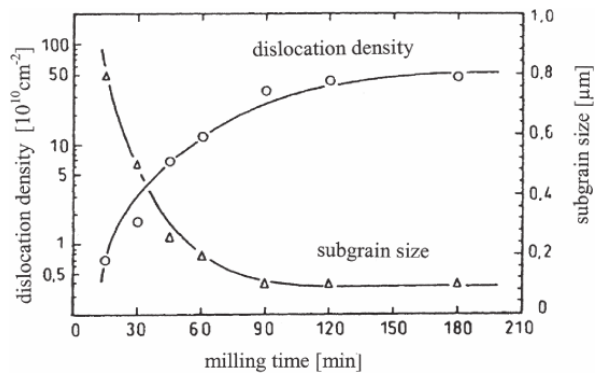
Fig. 1: Dislocation density and subgrain size in Al + 1 wt.% C